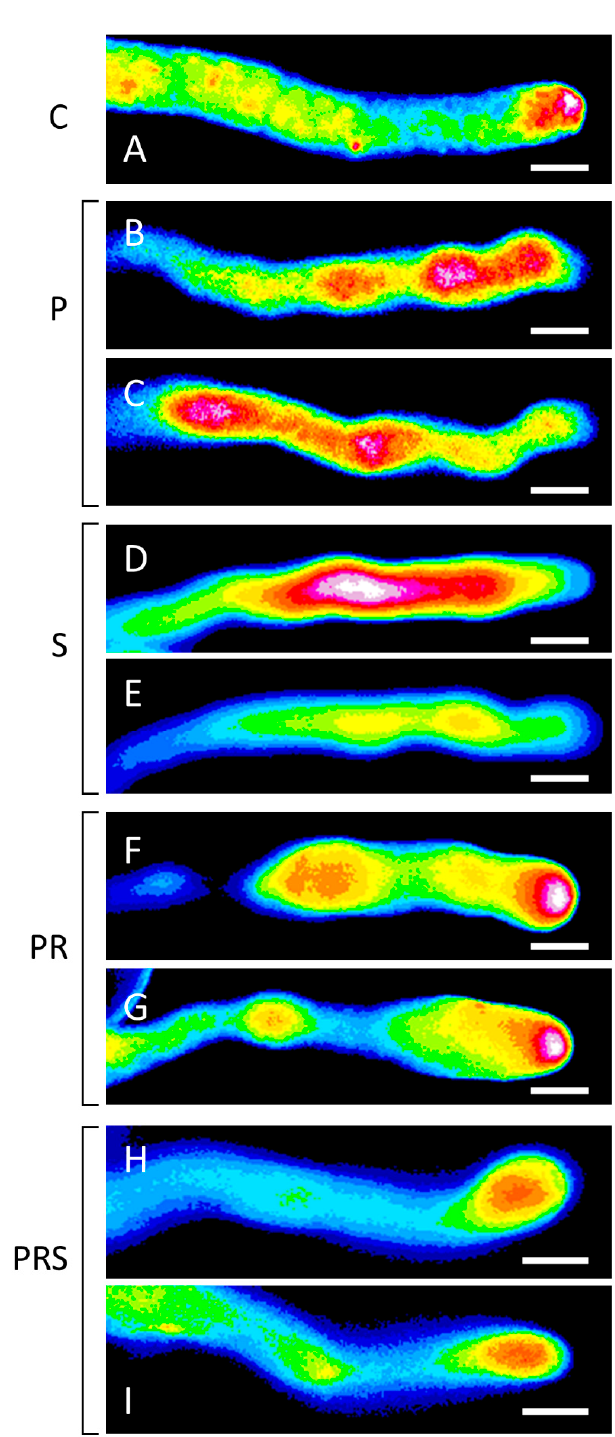
Figure 11. Distribution of cytosolic Ca 2+ in pollen tubes: ( A ) control sample (C), with the typical accumulation of cytosolic Ca 2+ at the pollen tube apex; ( B , C ) primed sample (P), with altered Ca 2+ gradient not always focused at the tube apex; ( D , E ) stressed sample (S), with Ca 2+ localized along the pollen tube but not in the apical region; ( F , G ) primed and recovered sample (PR), with diffuse signal along the pollen tube but more evident in the apical region; ( H , I ) primed, recovered and stressed sample (PRS), with Ca 2+ signal again localized to the tube apex although with less intensity. Figure reports the most representative images. At least 30 pollen grains and tubes were analyzed. Bars 10 µ